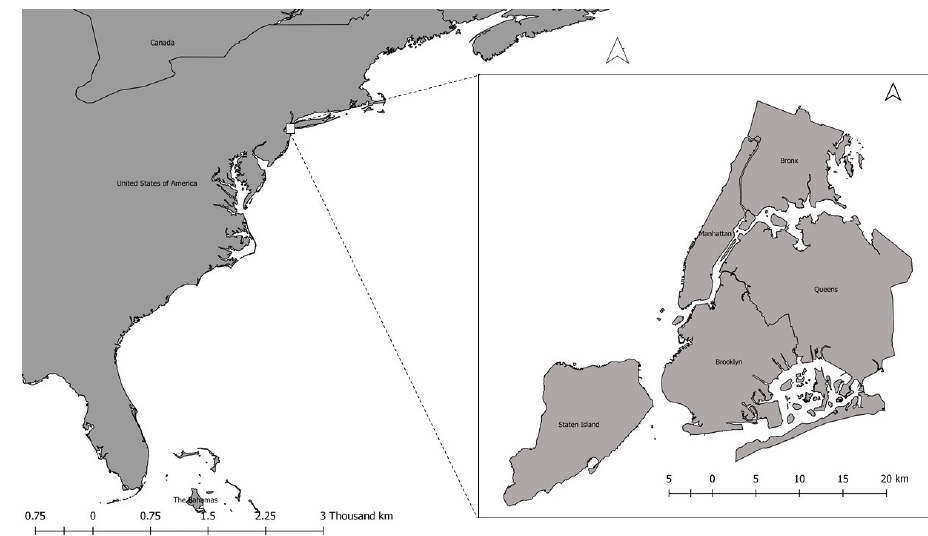
Figure 1. Location of New York City and a map of its